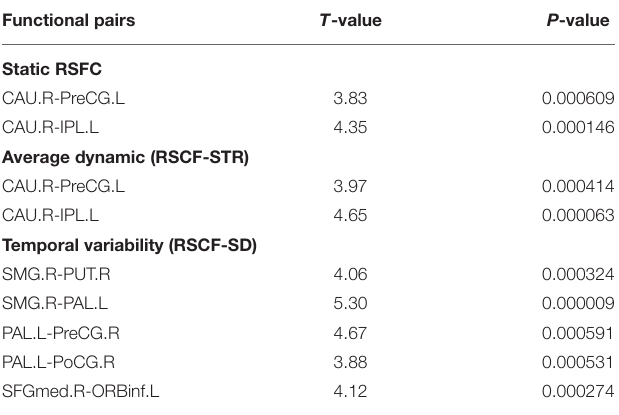
TABLE 3 | Group difference in state properties between HIV and HC groups and categorization of state network connectivity. State